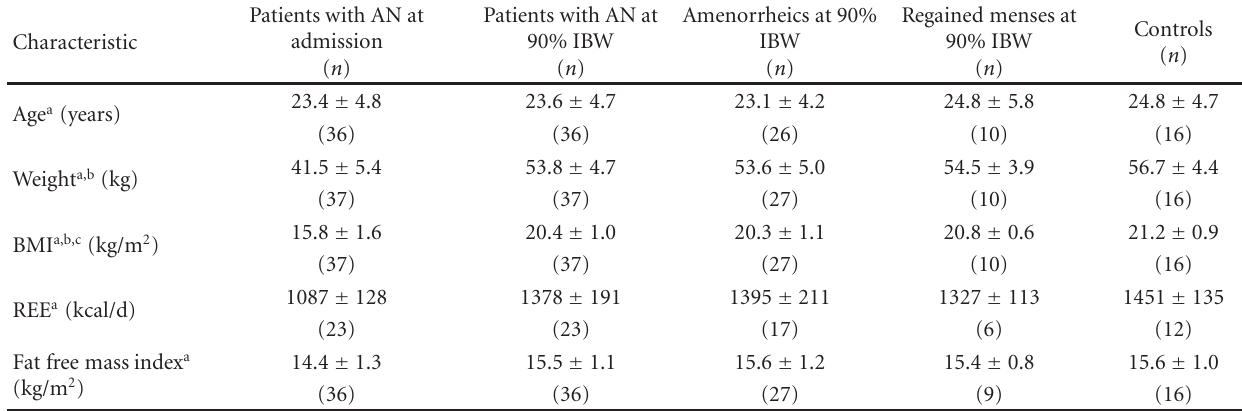
Table 1: Age and anthropometric measures (mean ±